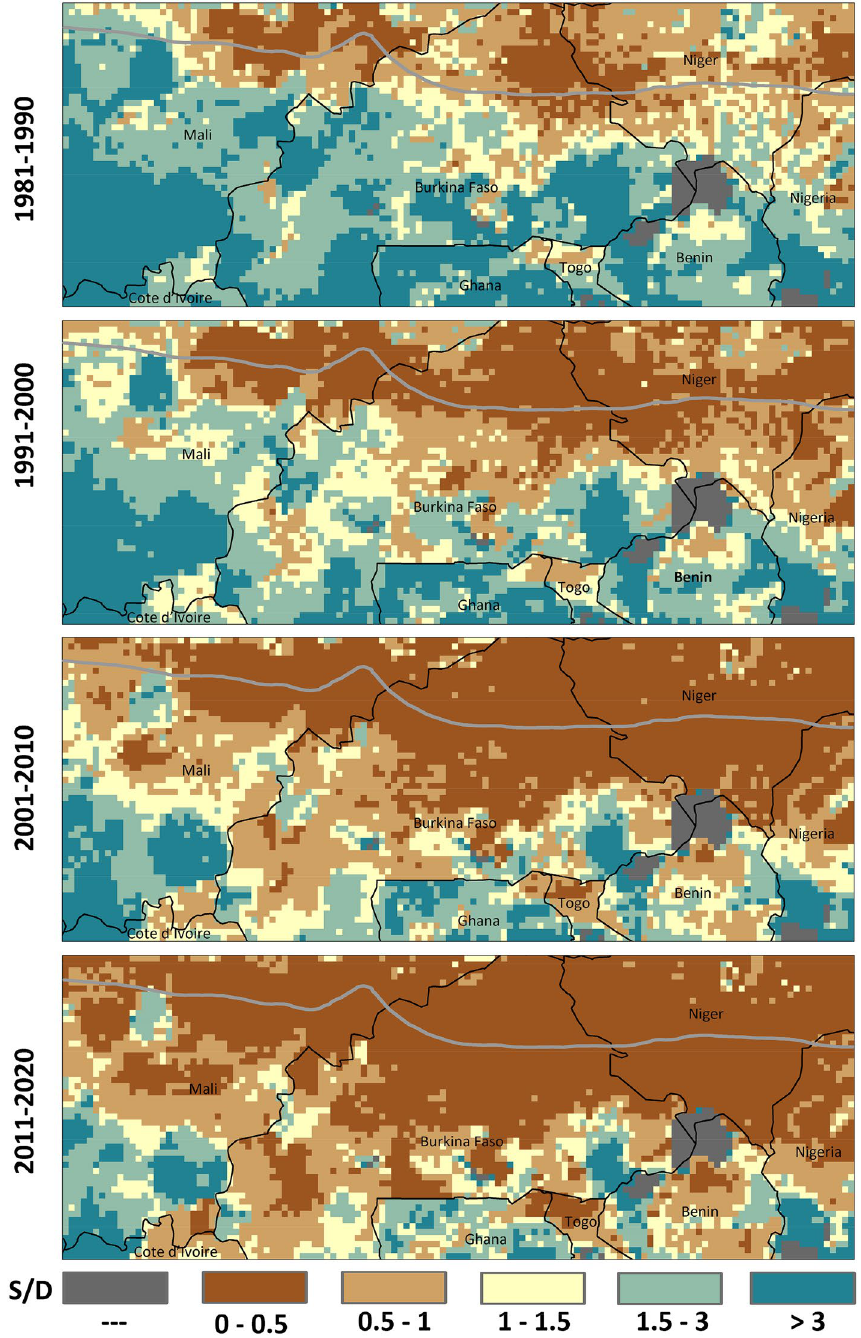
Figure 5. Spatial changes in supply versus demand balance (S/D) during the past four decades (1981–2020). Figures were generated using ArcGIS 10.8.1 (https:// www. esri. com/ en- us/ arcgis/ produ cts/ arcgis- pro/ overv